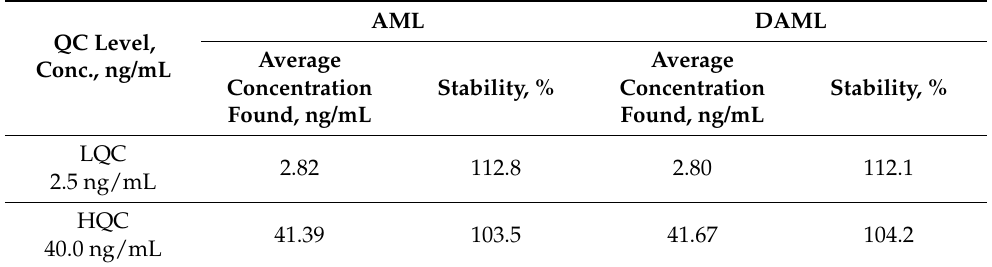
Table A10. On-instrument stability (24 h, 10 ◦ C) for AML and DAML in extracted human plasma